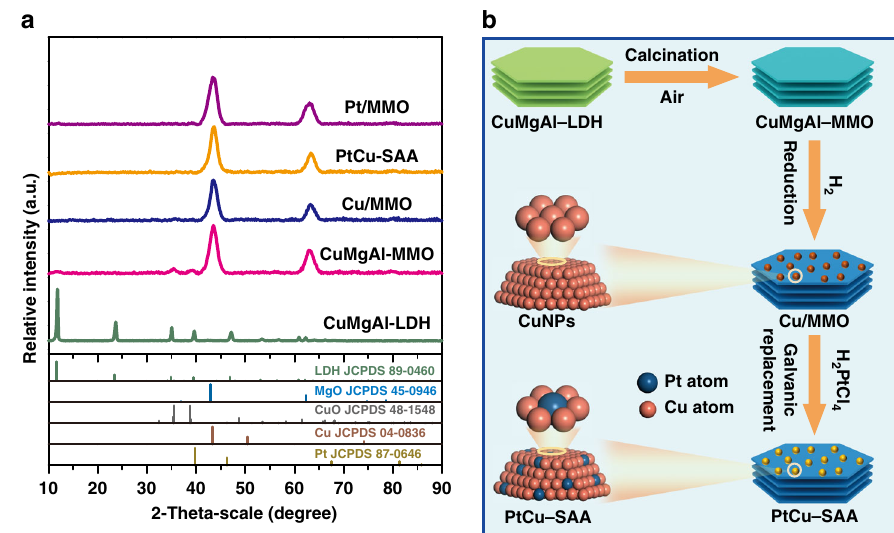
Fig. 1 Synthesis and characterization of PtCu – SAA from LDHs precursor. a In situ XRD patterns of various samples; b a schematic illustration for the preparation of PtCu –